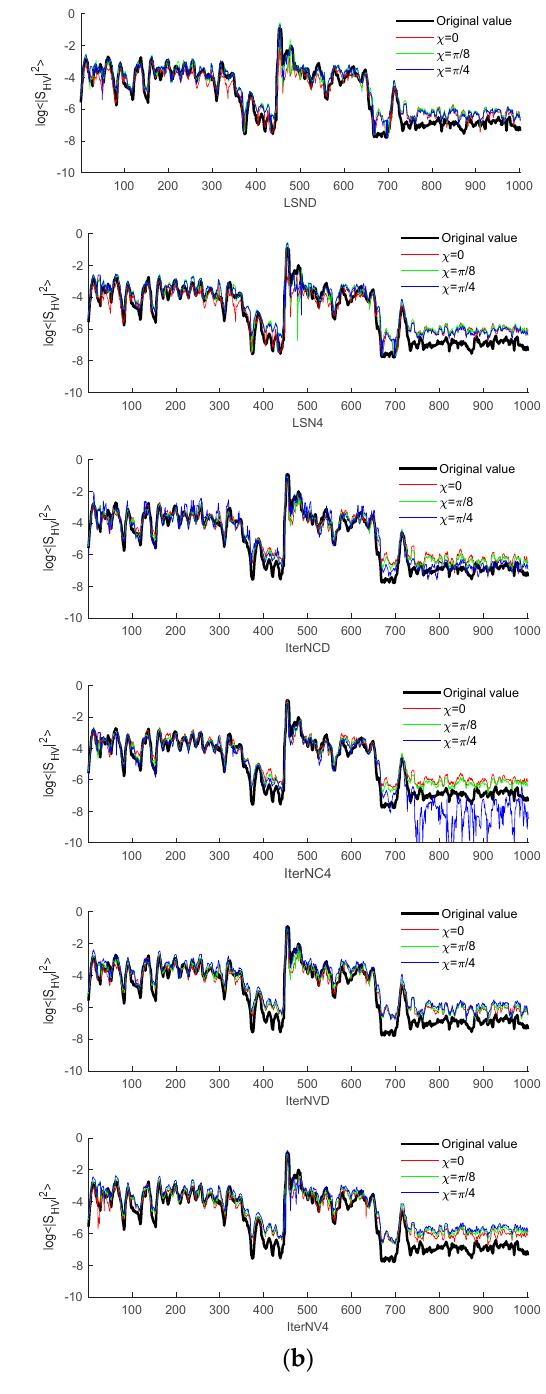
Figure 5. Estimate profiles for (cid:104)| S HV | 2 (cid:105) along the transect lines in Figure 2. ( a ) ALOS-2/PALSAR San Francisco data, where the four transect lines indicate data from ocean surface, forests, urban areas without obvious rotation, and tilted urban areas, respectively; ( b ) RADARSAT-2 Fuzhou data.